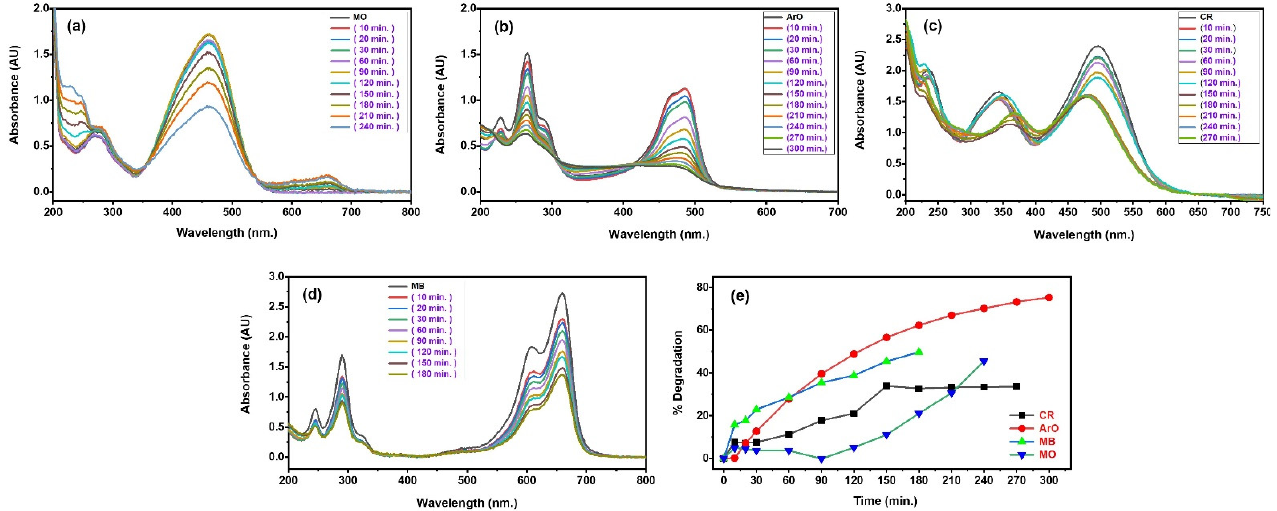
Figure 8. UV–vis absorption spectra for the photodegradation of ( a ) MO (0.07 mM), ( b ) ArO (0.07 mM), ( c ) CR (0.07 mM), and ( d ) MB (0.07 mM) under solar light using Cu@Alg/Co–CeO 2 catalyst (4 beads). ( e ) % Degradation of ArO as a function of time. catalyst (4 beads). ( e ) % Degradation of ArO as a function of